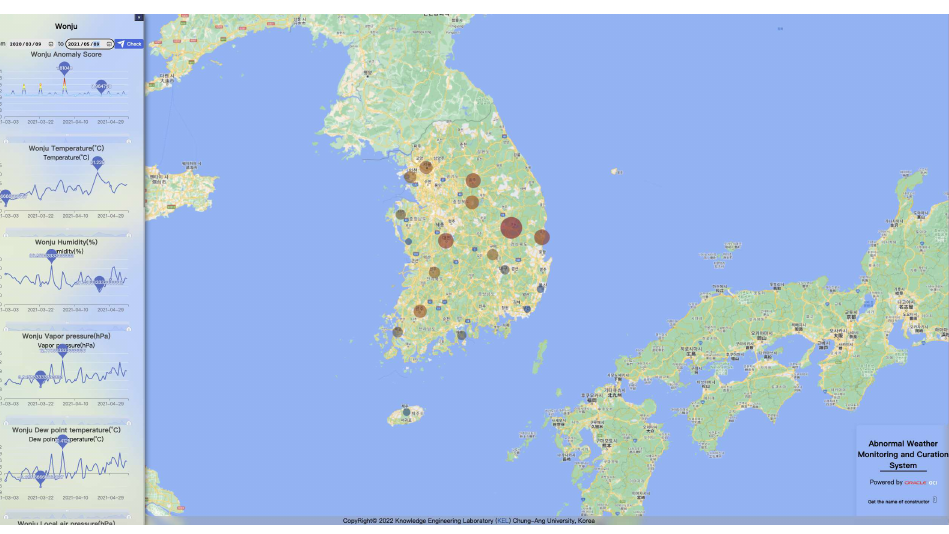
Figure 3. Example of the user